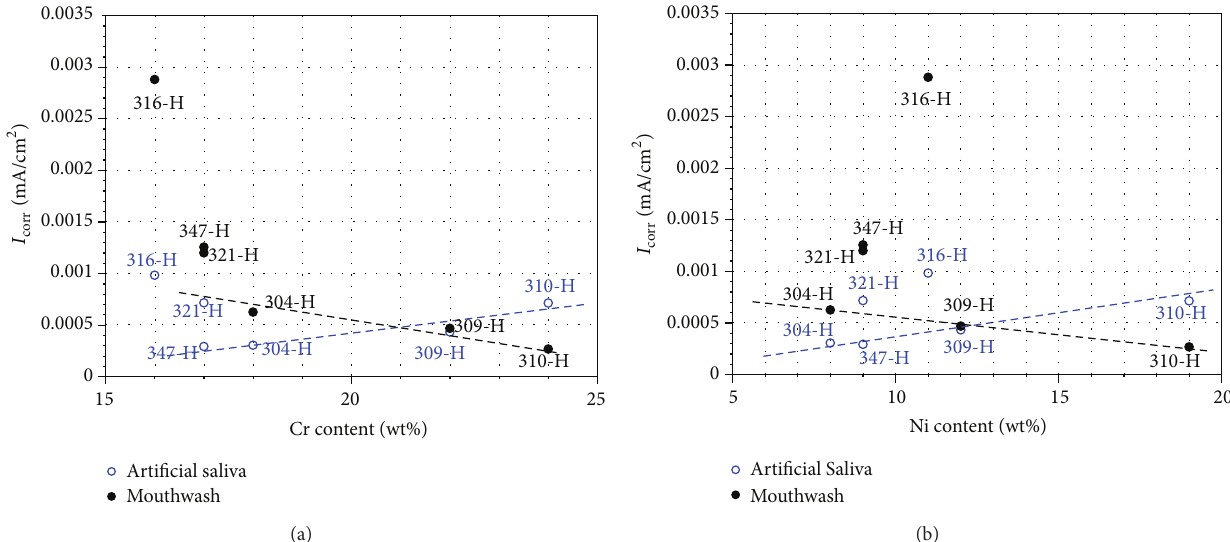
Figure 12: Effect of Cr and Ni content of stainless steels on 𝐼